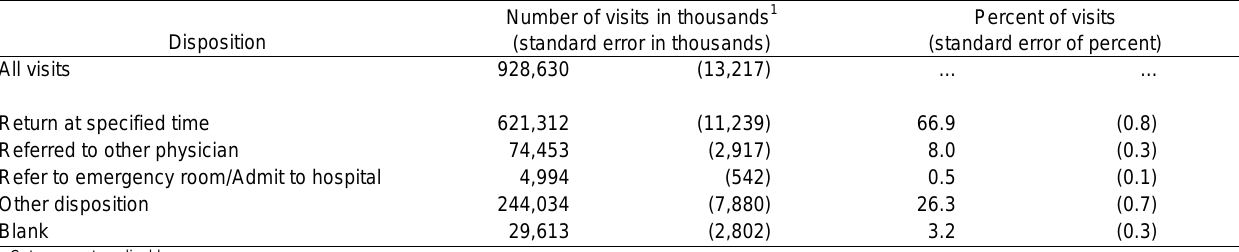
Table 28. Disposition of office visits: United States,